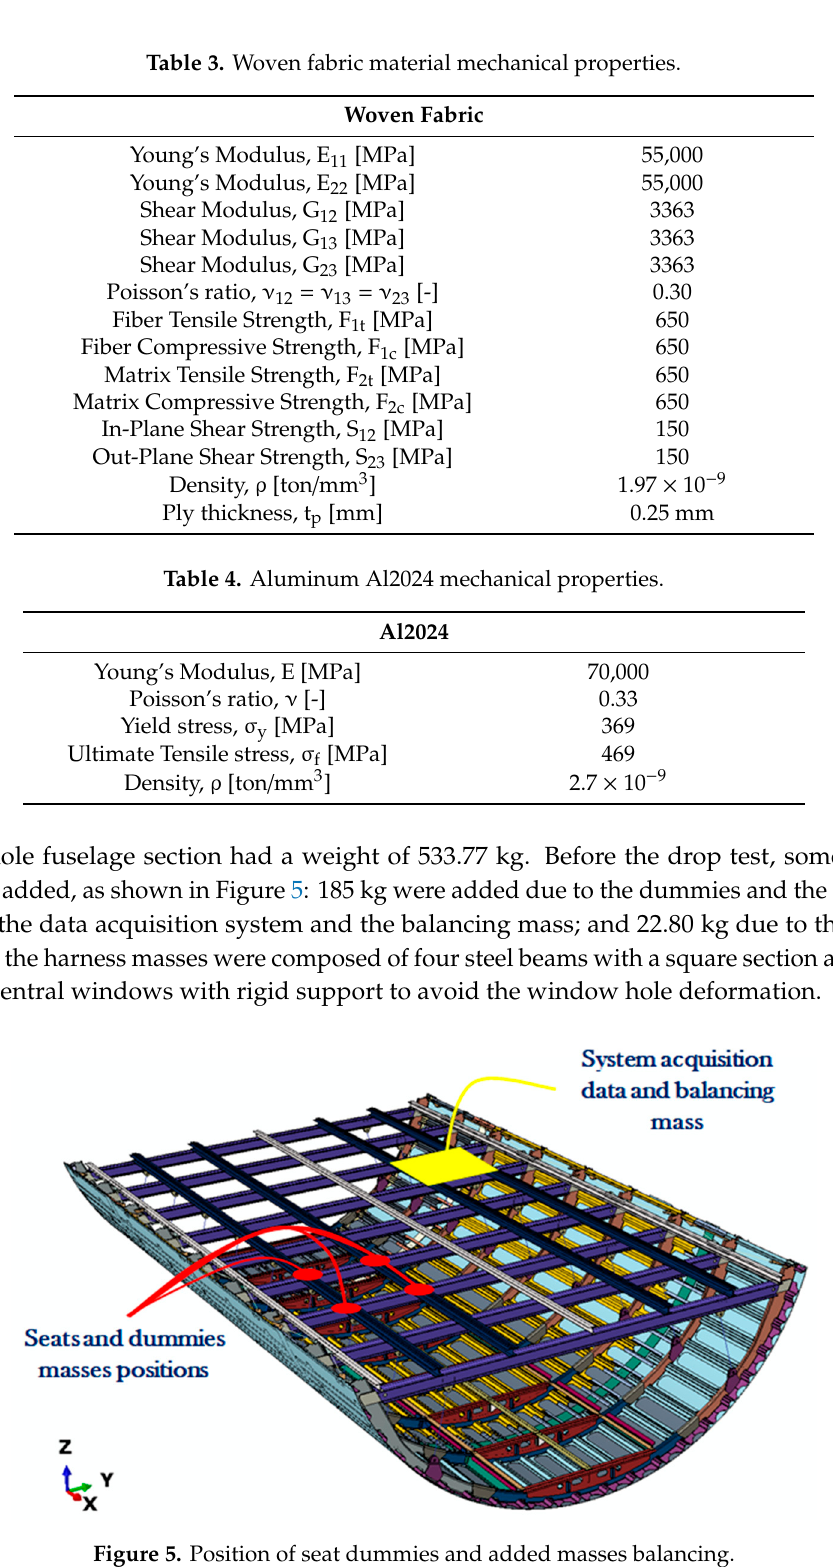
Table 3. Woven fabric material mechanical properties.